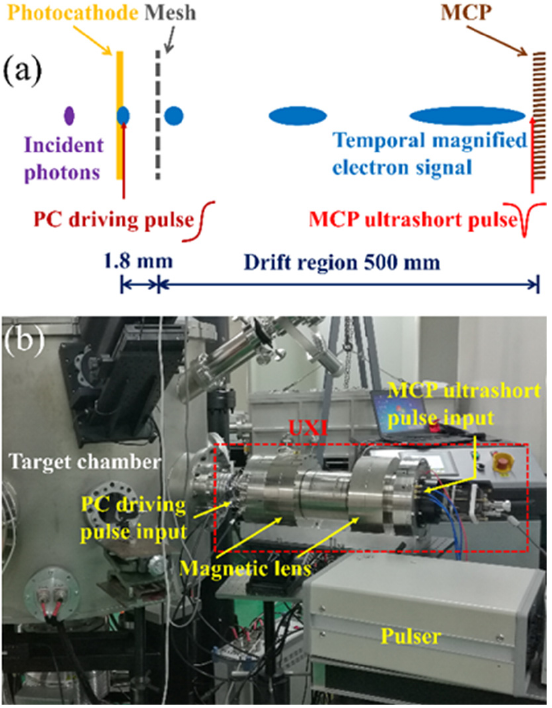
Figure 1. ( a ) UXI schematic diagram; ( b ) UXI (as shown in the red box) mounted on the target chamber.